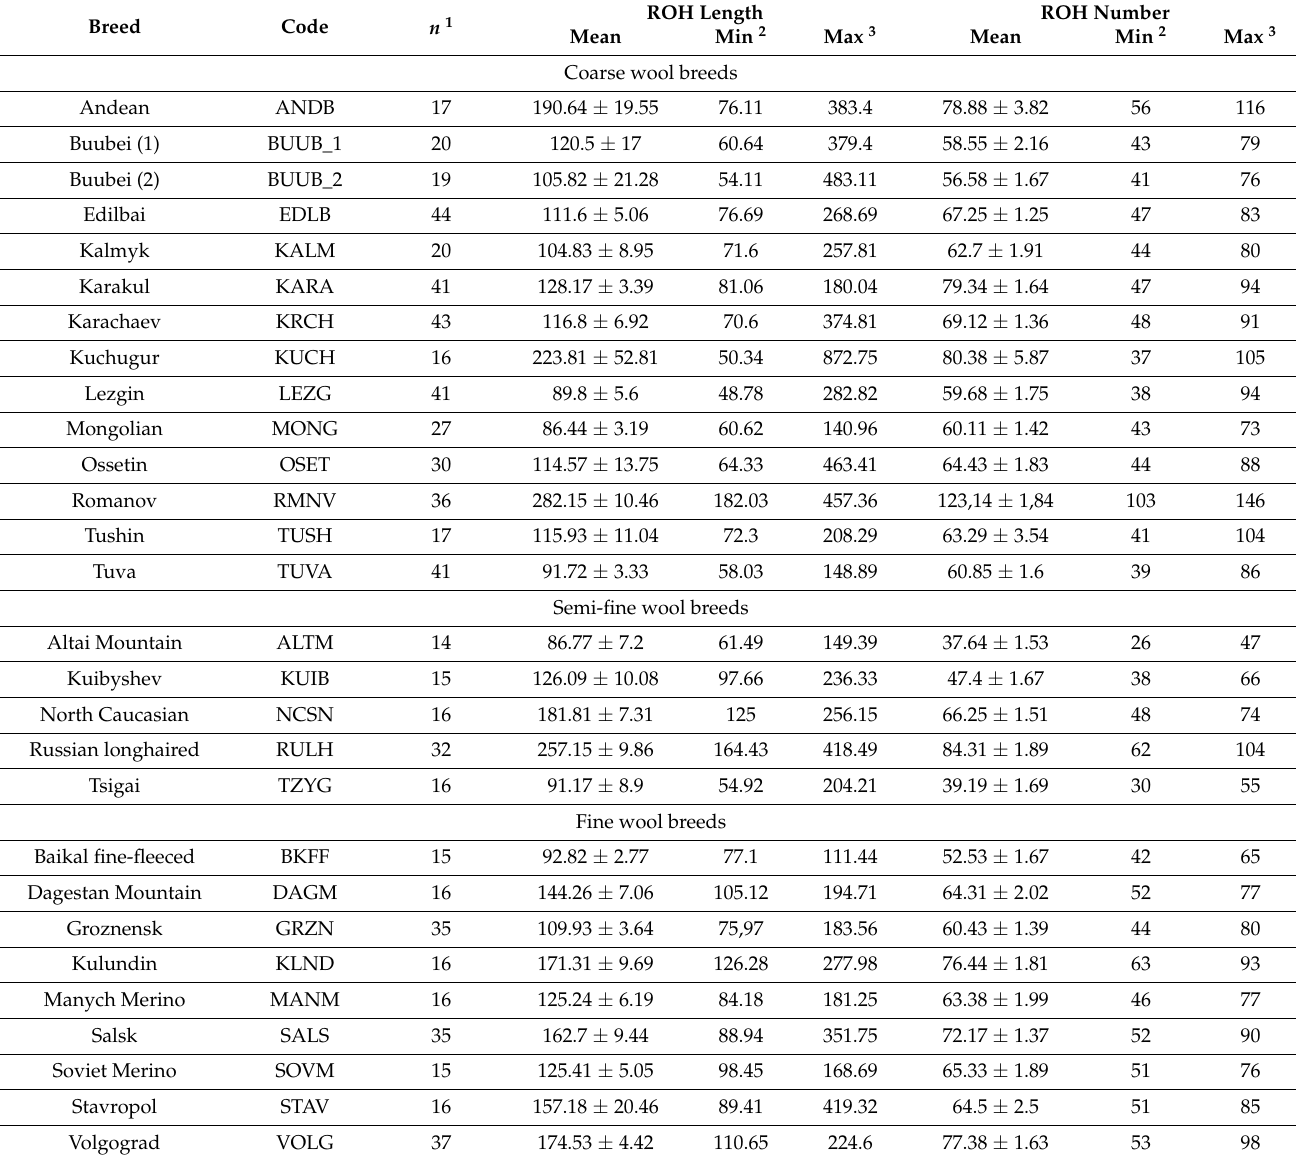
Table 2. Mean ROH length and mean ROH number in Russian sheep